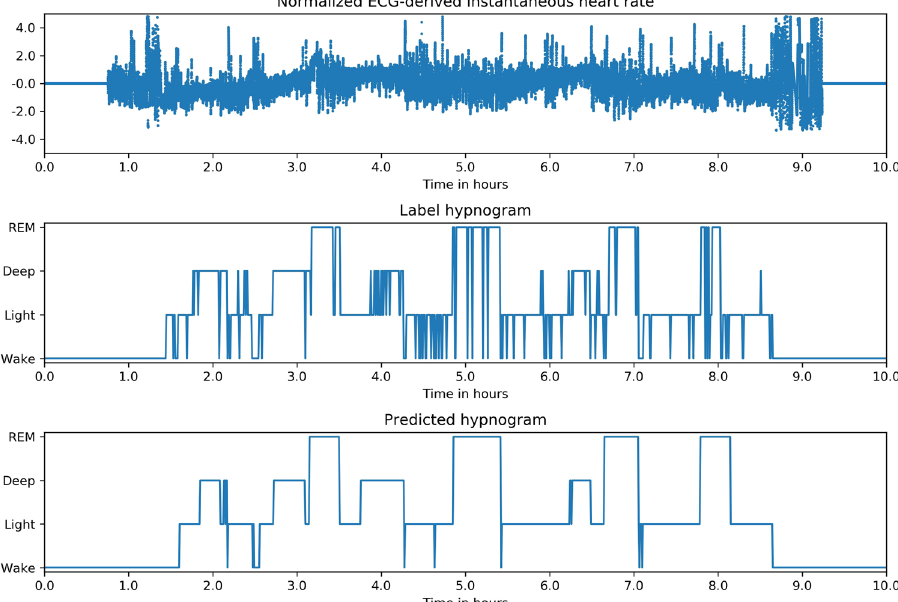
Fig. 2 Example of Inputs, labels and predictions. Hypnogram of a healthy subject shows typical 60 – 90 min sleep cycles with more deep sleep in the fi rst half of the night and more REM in the second half. The predicted stages track the reference very well and are also “ smooth ” compared with the reference, i.e they have fewer rapid stage bouts that only last 1 or 2